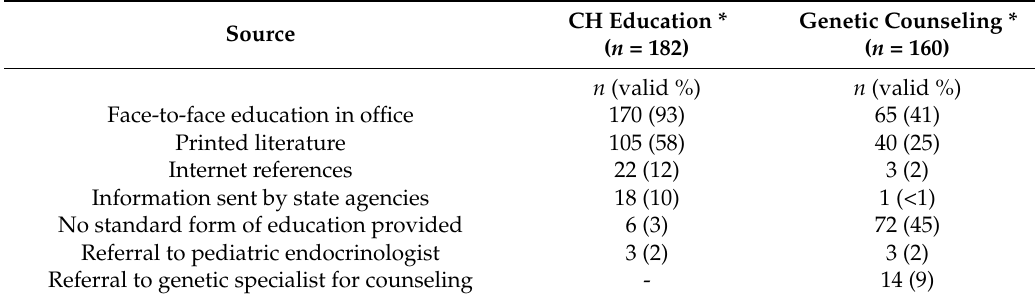
Table 4. Percentage of clinicians reporting forms of CH education and genetic counseling provided by their practice.